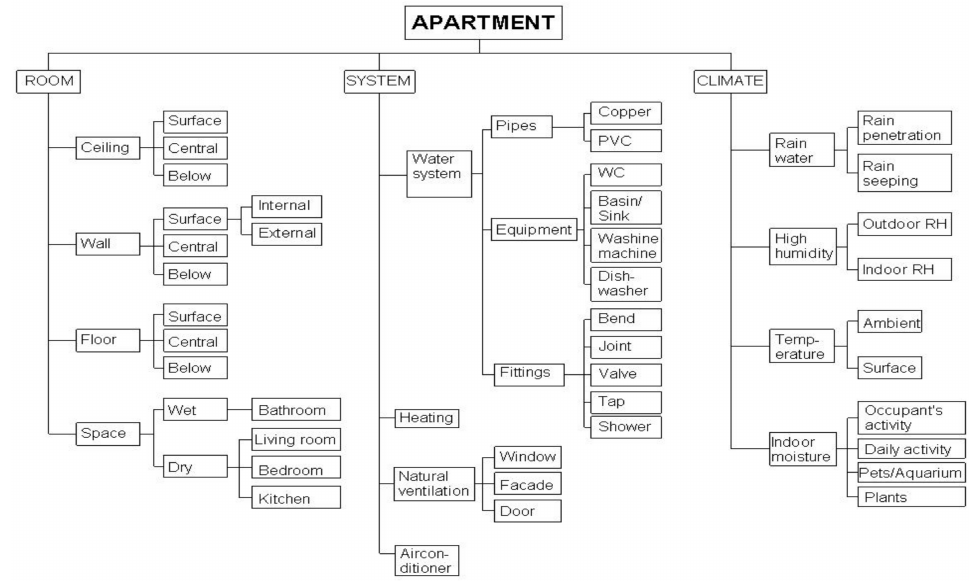
Figure 3. FMEA outline for apartment unit source.